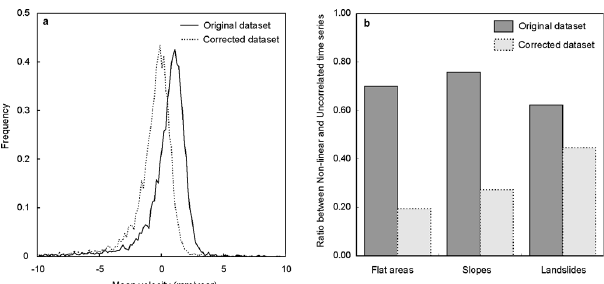
Fig. 14. Application of PS-Time to the biased dataset “Ligonchio”. (a) frequency distribution of the mean PS velocity of the original (solid line) and corrected (dashed line) dataset; (b) relative fre- quency of non-linear time series in the three morphological units for the biased and corrected